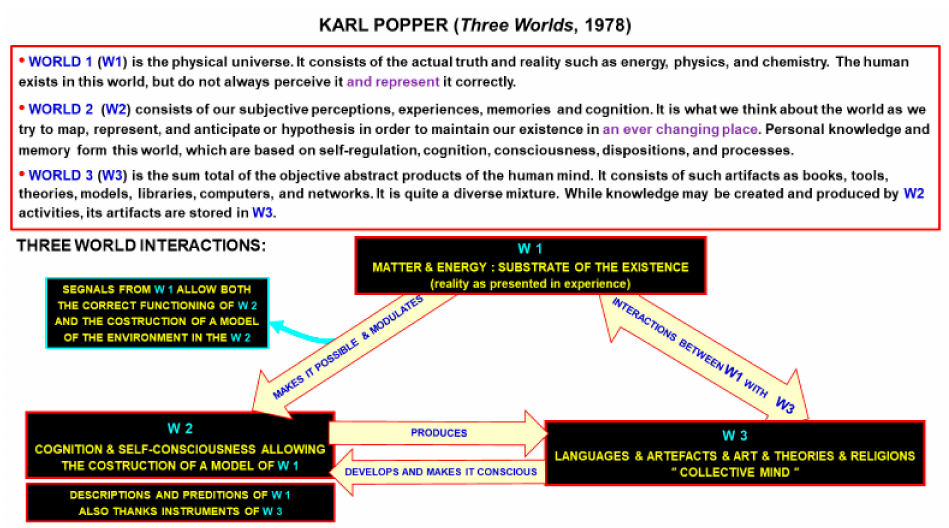
Figure 3. Schematic representation of Popper’s three worlds